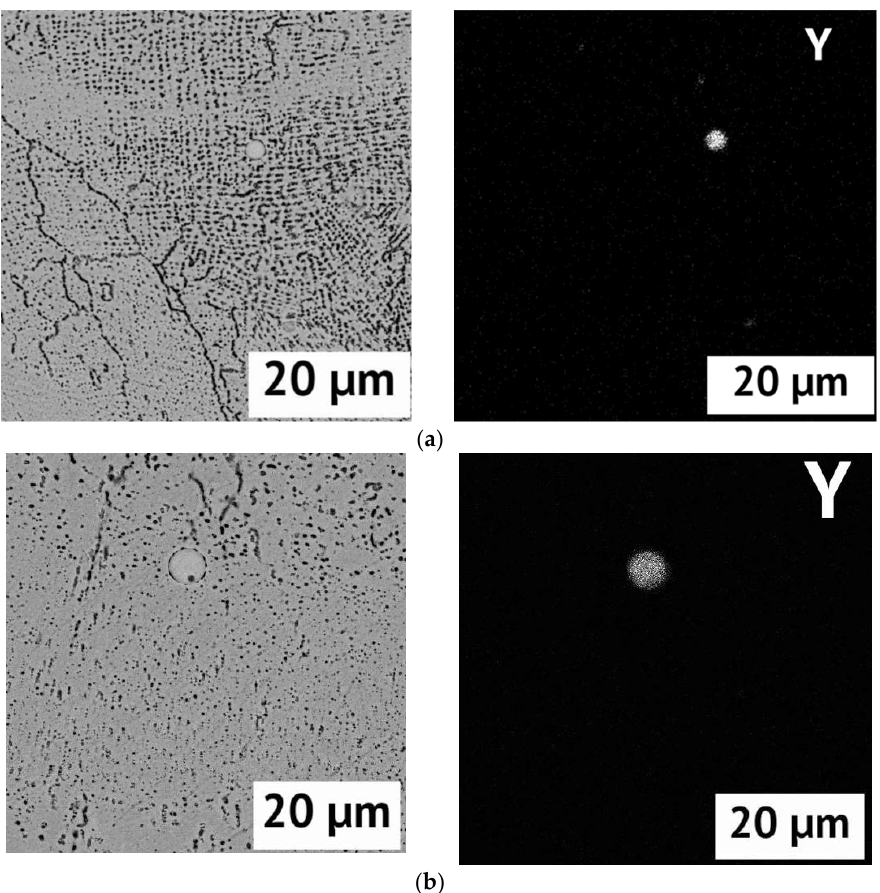
Figure 3. SEM images (left) and corresponding EDS maps of Yttrium distribution (right) of samples with 1% Y (double laser processing): ( a ) after SLM; ( b ) after heat treatment. with 1% Y (double laser processing): ( a ) after SLM; ( b ) after heat